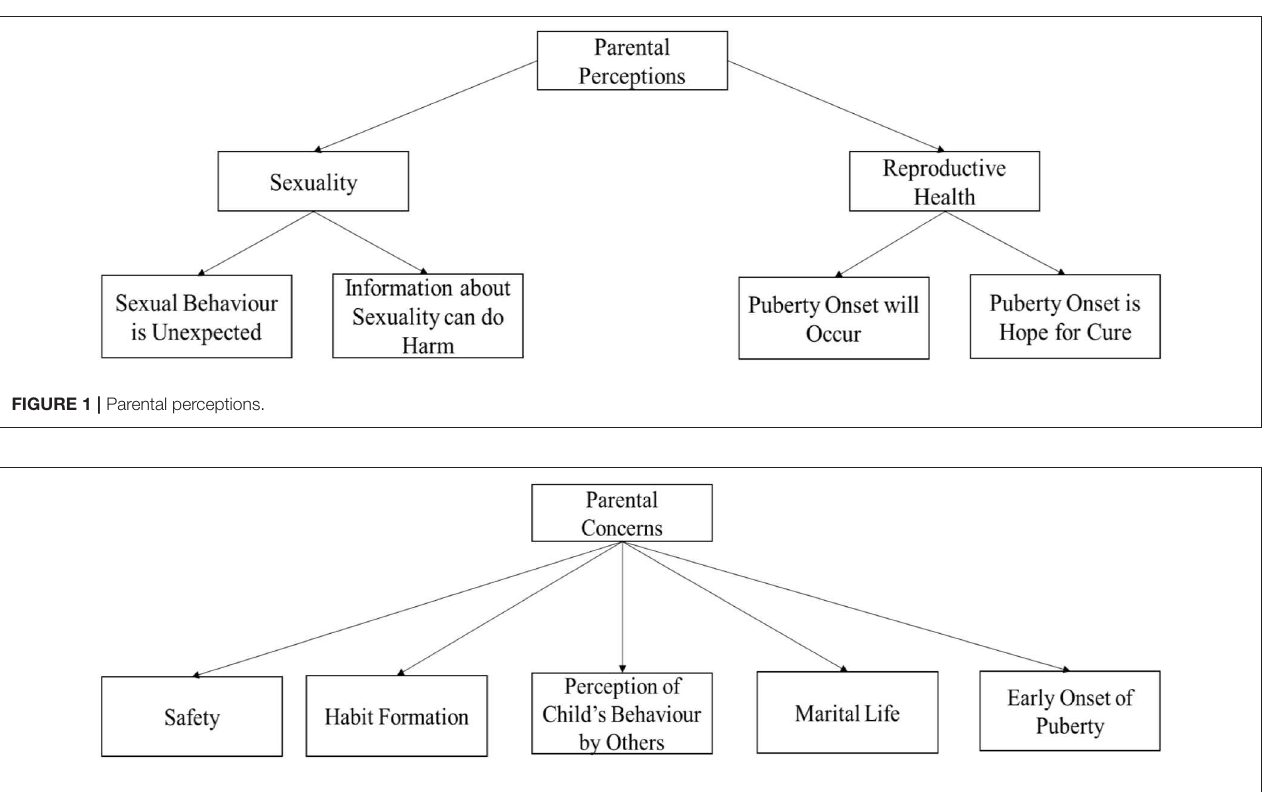
FIGURE 2 | Parental